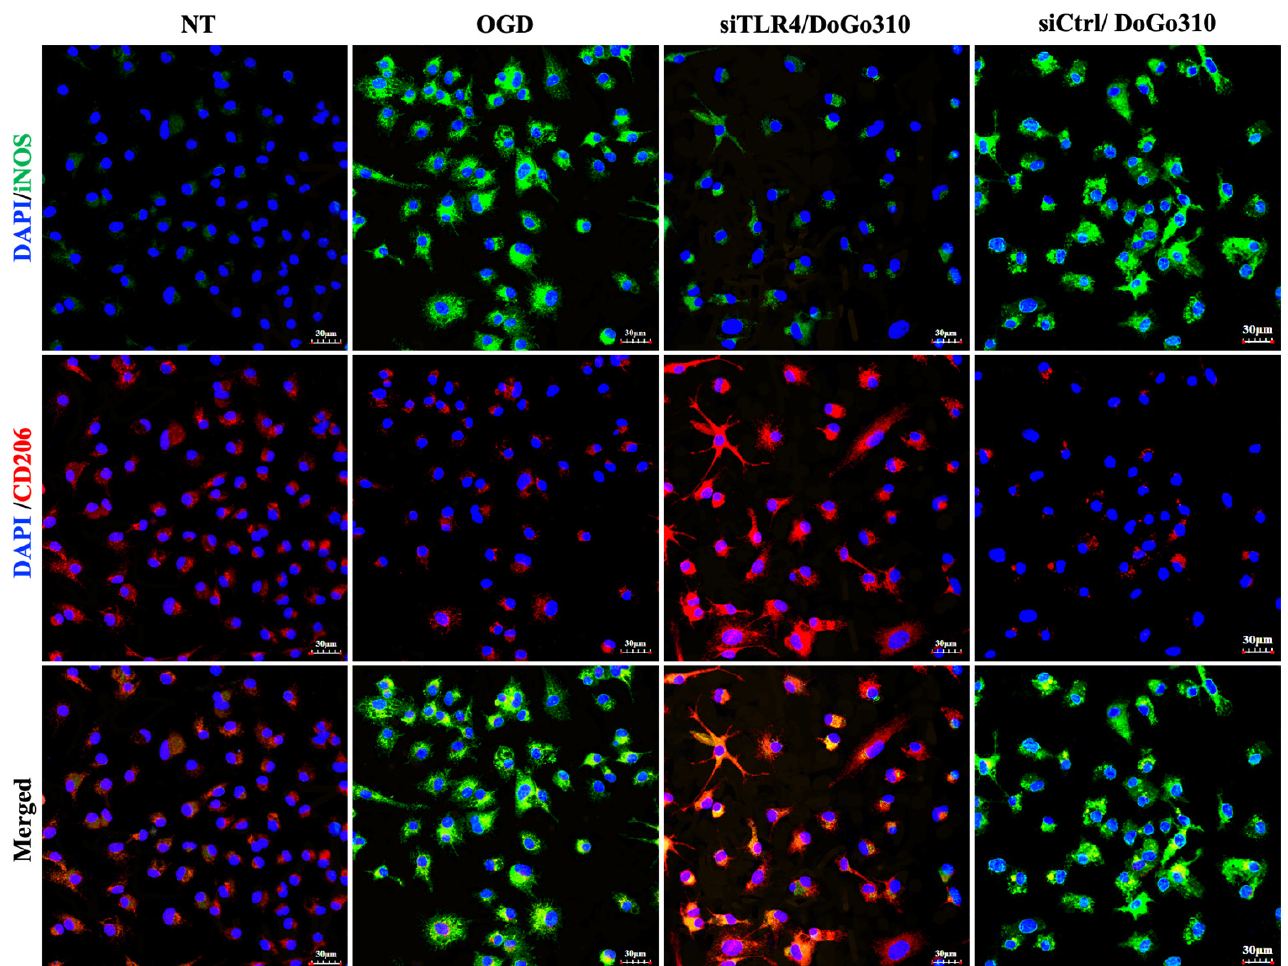
Figure 4. DoGo310 LNP-mediated delivery of siTLR4 reverse microglia polarization in vitro. Im- munocytochemistry analysis showing the downregulated expression of M1 polarization marker iNOS (green), and upregulated expression of M2 polarization marker CD206 (red) in siTLR4/DoGo310 LNP-treated cells but not in siCtrl/DoGo310 LNP-treated cells. NT, nontreated.